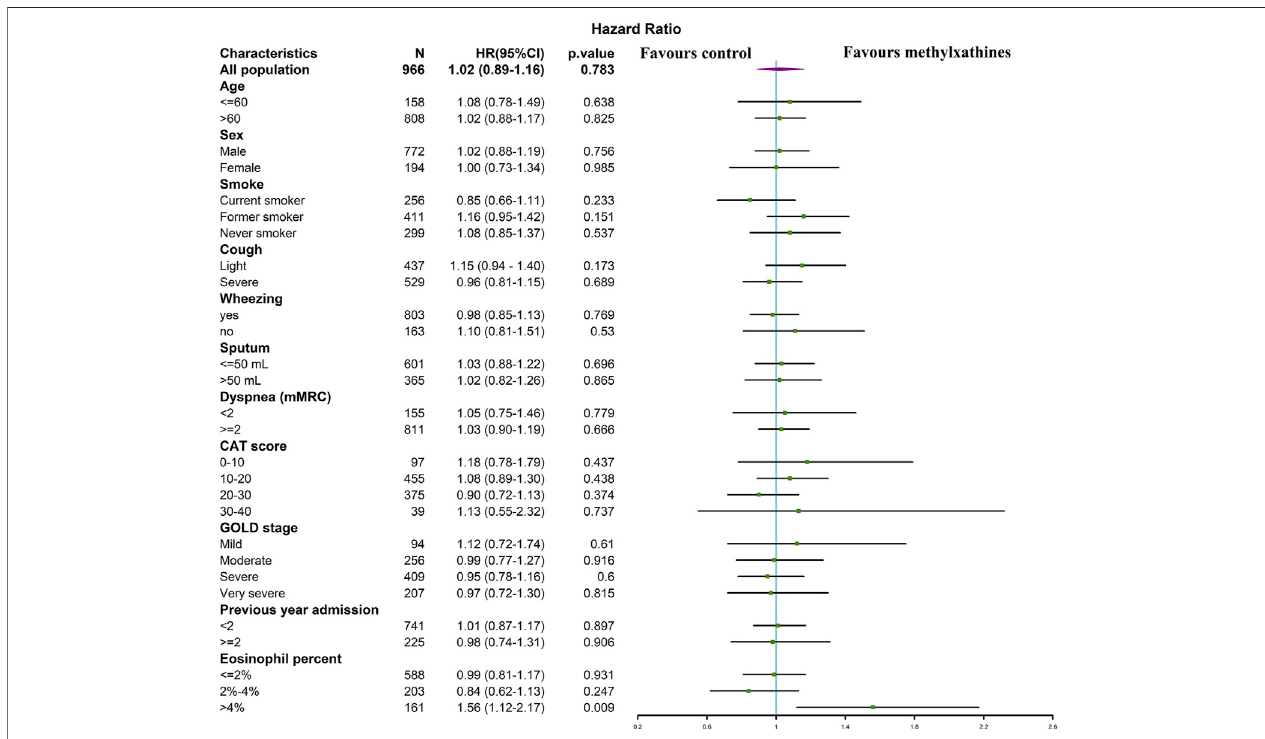
FIGURE 3 | The association between LOS and methylxanthines use in subgroups of matched cohort. Variables increase the length of stay if HR < 1, whereas variables reduce the length of stay if HR > 1.